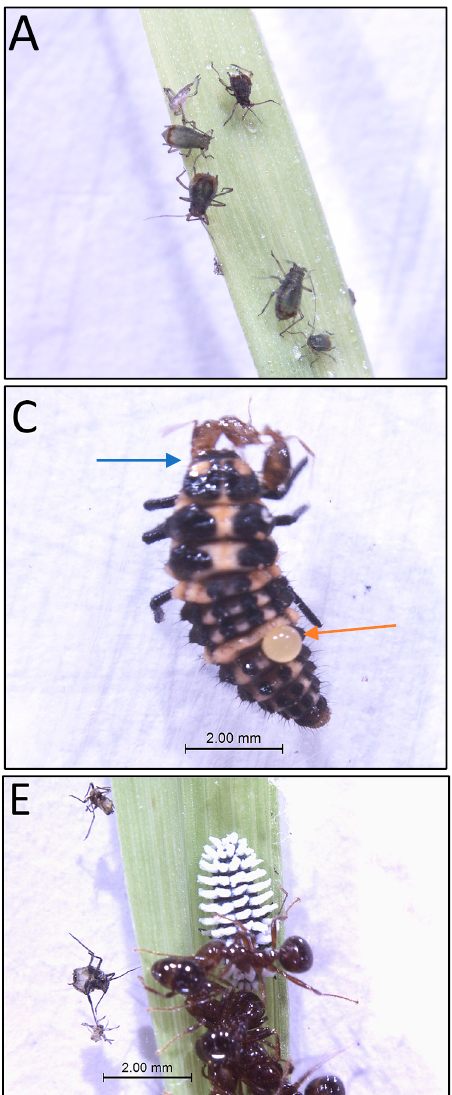
Figure 1. ( A – E ) Images of R . padi nymphs and adults on barley leaf ( A ) and other R . padi individuals consumed by 3rd instar C. maculata ( B ). Image of S. invicta worker attacking 3rd instar C. maculata ( C ) in the arena. The blue arrow illustrates S. invicta biting C. maculata ; the orange arrow illustrates a drop of hemolymph exuding from the integument of C. maculata after being stung by S. invicta . Images of 3rd instar Sc. creperus not being attacked by S. invicta workers ( D , E ). The mean ± SE number of R. padi killed by 3rd instar C. maculata was significantly lower in the presence of S. invicta ( t = 3.32, df = 38, p = 0.002; Figure 2A). Solenopsis invicta did not kill or tend R. padi nymphs or adults. The mean ( ± SE) proportion of R. padi killed during the 7-h test period was 0.46 ( ± 0.05) and 0.66 ( ± 0.02) in the C. maculata and S. invicta treatment versus C. maculata alone treatment, respectively. There were 60 R. padi nymphs and adults in each arena at the onset of the experiment with C. maculata . Solenopsis